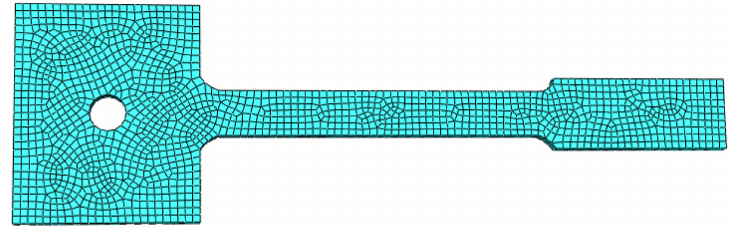
Figure 15. FE model of MTS specimen.